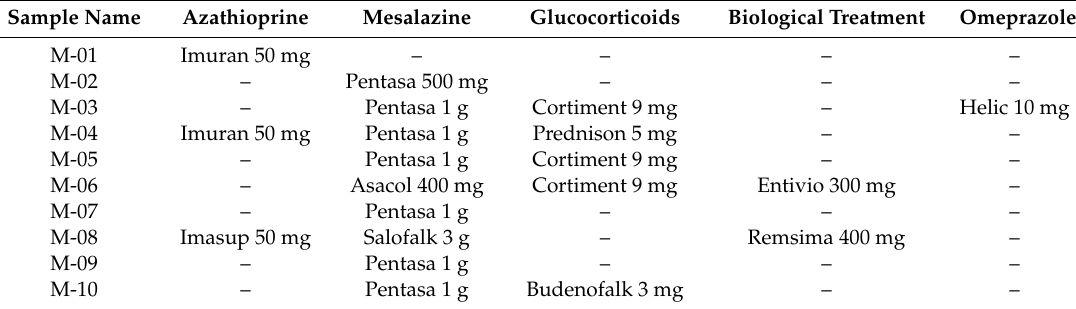
Table 2. Prescribed and taken therapeutics assigned to IBD sample donors